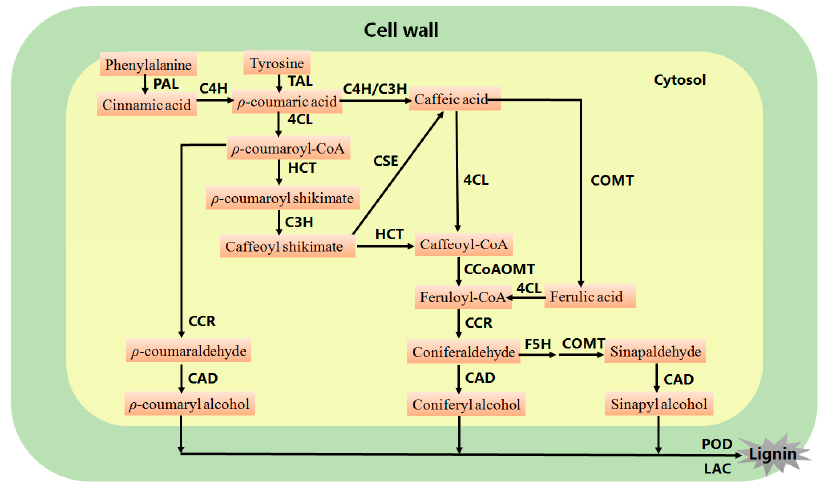
Figure 1. The general biosynthesis pathway of lignin in higher plants. PAL, phenylalanine ammonia-lyase; TAL, tyrosine ammonia-lyase; C4H, cinnamate 4-hydroxylase; 4CL, 4-coumarate: CoA ligase; CCR, cinnamoyl-CoA reductase; HCT, hydroxycinnamoyl-CoA shikimate/Quinatehydroxycinnamoyltransferase; C3H, p -coumarate 3-hydroxylase; CCoAOMT, caffeoyl-CoA O -methyltransferase; F5H, ferulate 5-hydroxylase; CSE, caffeoyl shikimate esterase; COMT, caffeic acid O -methyltransferase; CAD, cinnamyl alcohol dehydrogenase; LAC, laccase; POD, peroxidase.